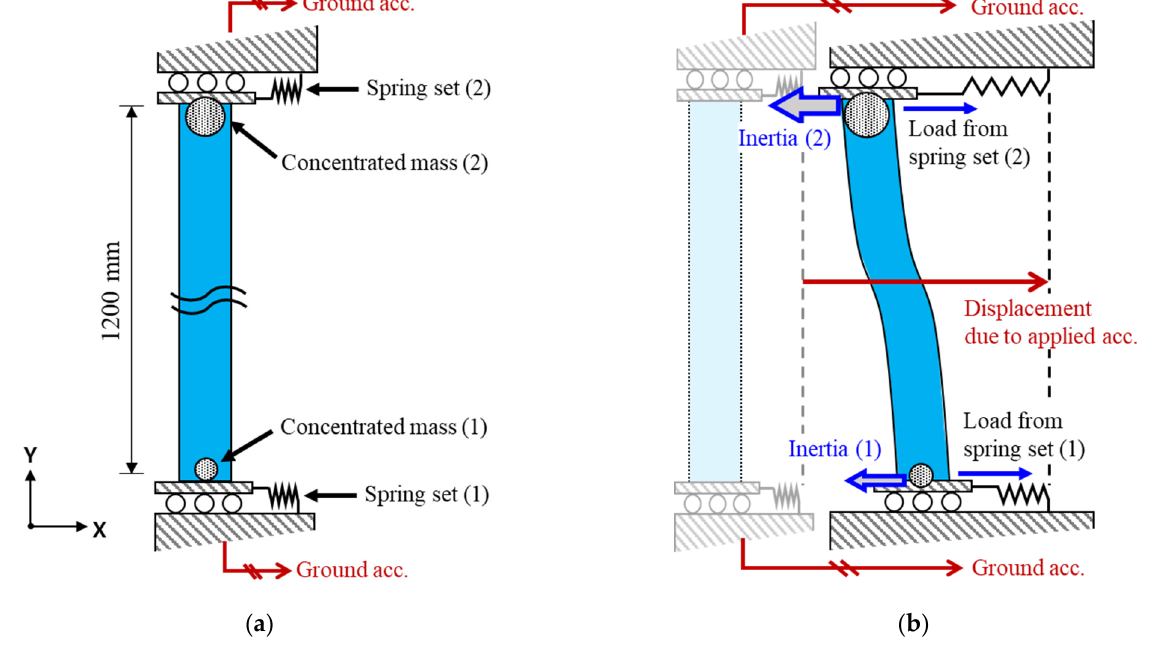
Figure 10. Simplified model for dynamic optimization: ( a ) Model configuration; ( b ) Deflection of the model under the applied excitation.